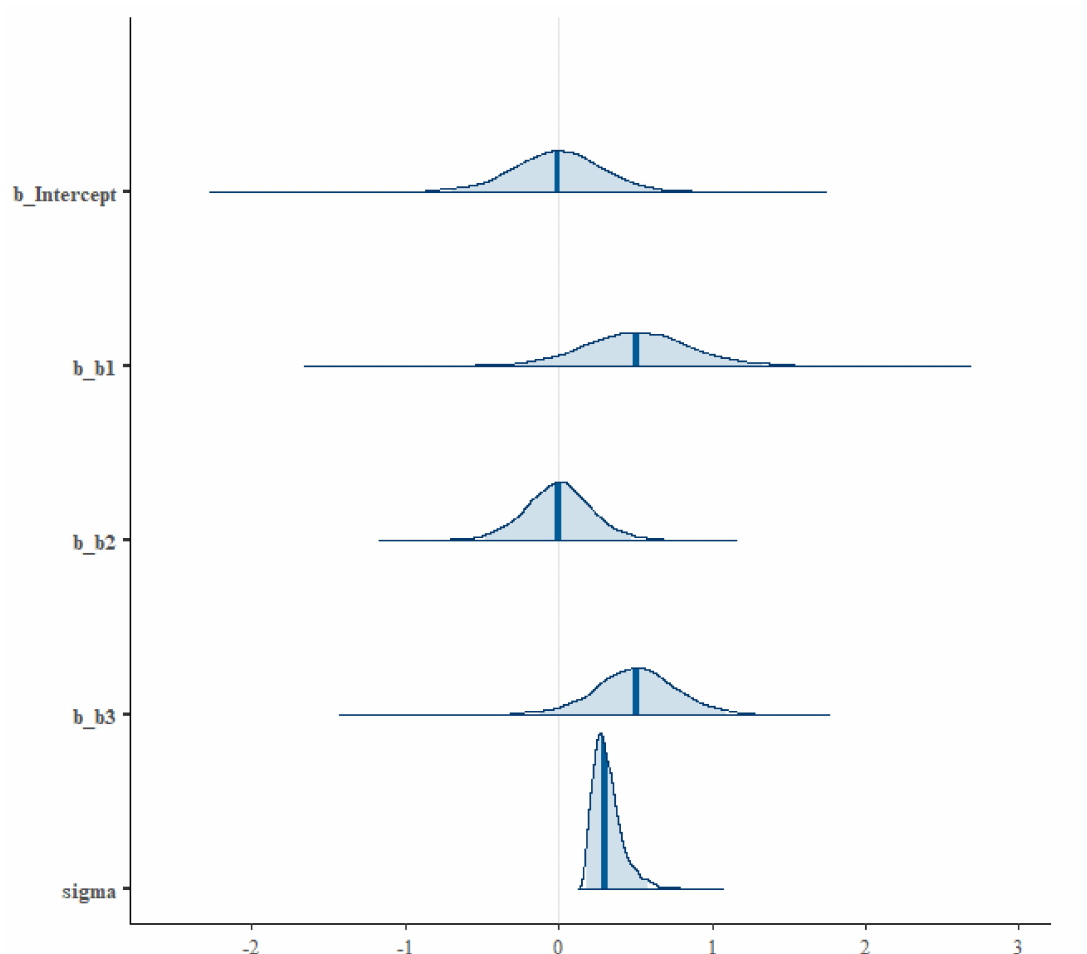
Figure 16. Density plot of the fitted regression model, generated using the brms R package [53–55]. The coefficients are labelled with a prefix “b_”; this is due to auto generation by the relevant R func‑ tion. b_intercept corresponds to β o ; and b_b1, b_b2 and b_b3, respectively, correspond to β 1 , β 2 . and β 3 of the model. The shaded blue area indicates the 95% credibility